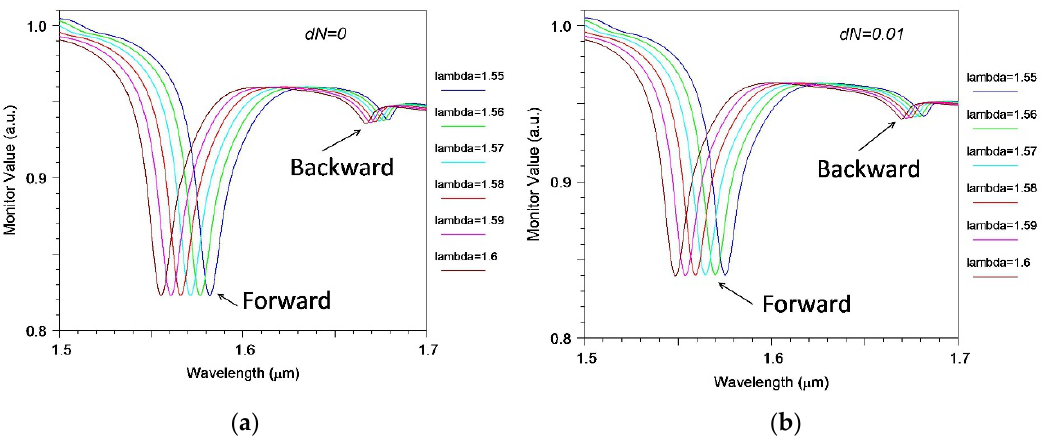
Figure 6. Transmission spectrum of silicon waveguide in the presence of a periodic segmented structure surrounded by water, calculated for different wavelengths of pulsed excitation and different small changes dN refractive index of the environment: ( a ) dN = 0.0; ( b ) dN = 0.01.